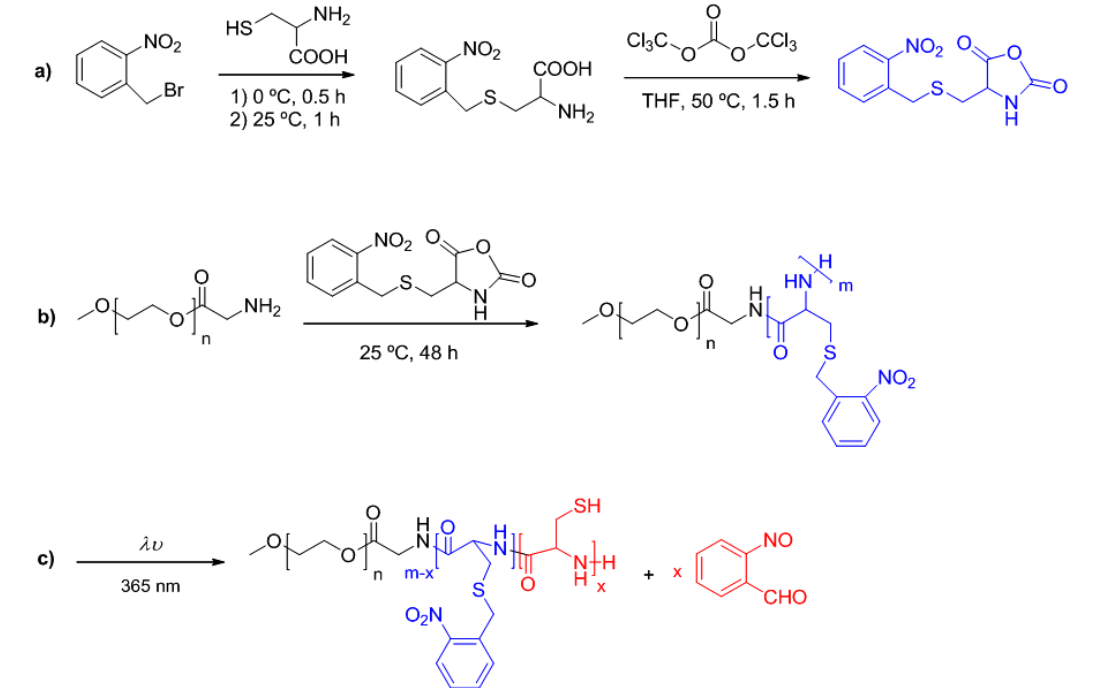
photocleavage reaction ( c